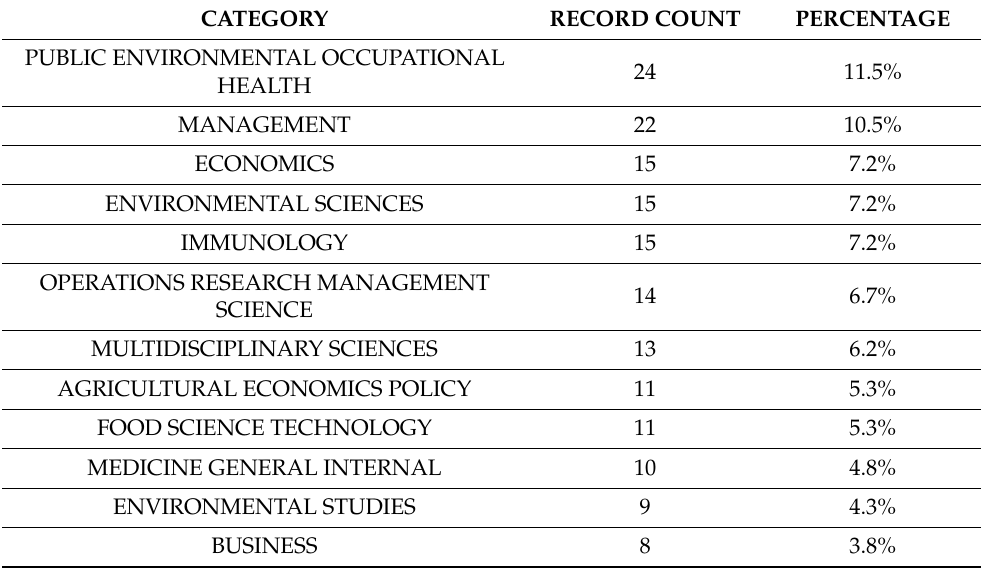
Table 2. Research Articles by